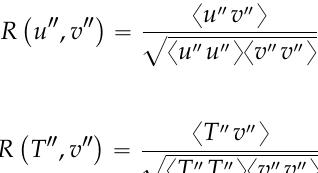
Their profiles at x = 40.775 are plotted in Figure 15. For both (cid:1844)(cid:4666)(cid:1873)′′,(cid:1874)′′(cid:4667) and (cid:1844)(cid:4666)(cid:1846)′′,(cid:1874)′′(cid:4667) , we can identify a near ‐ wall peak for Case 0, which stands for the contribution of certain organized turbulence motions in the near ‐ wall region, as proposed by Kim et al. [46] for the incompressible channel flow. The strength of the near ‐ wall peaks of (cid:1844)(cid:4666)(cid:1873)′′,(cid:1874)′′(cid:4667) is effectively suppressed due to the restrain of near ‐ wall turbulence and we can get a similar change of (cid:1844)(cid:4666)(cid:1846)′′,(cid:1874)′′(cid:4667) in the near ‐ wall region, which indicates the consistent effects of SWO on organized velocity and temperature structures as well as on momentum and heat transports.